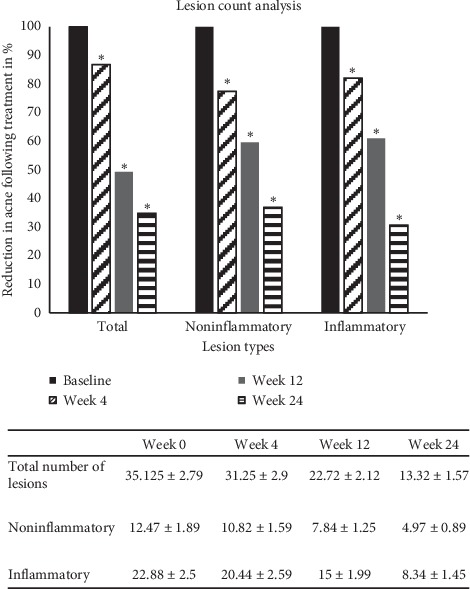
Quantitative analysis indicating percentage reduction in acne lesions. Lesion counts of total acne including the inflammatory and the noninflammatory types at week 0 (100%), 4, 12, and 24 are represented. ∗Statistical significance of P < 0.05, based on Student's t-test. The table provides the corresponding values as average ± SEM.